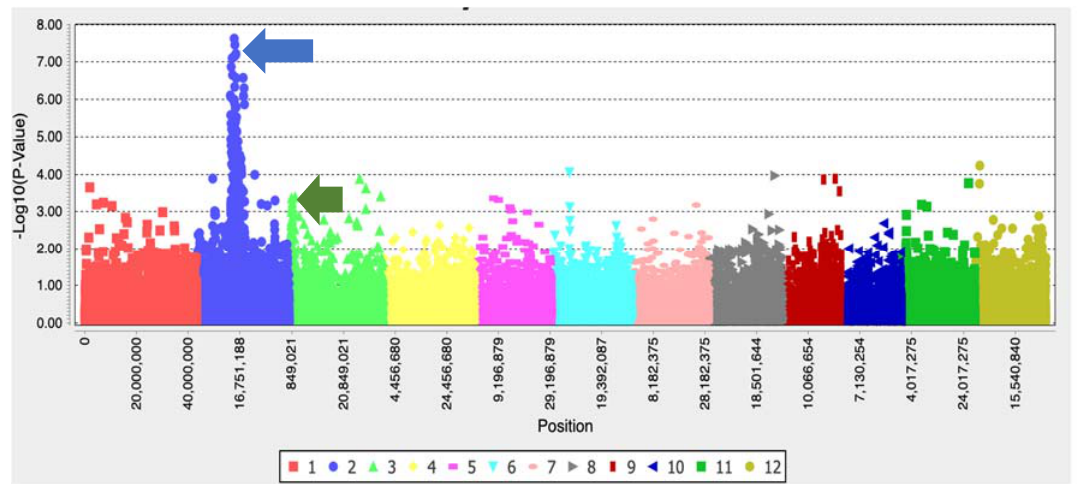
Figure 4. Manhattan plot showing a peak on chromosome 2 (blue arrow) (with –log10 ( p -value) > 5.8) where the ALS gene is located. A lower peak on chromosome 3 (green arrow) was identified as a potential gene contributing toward IMI resistance in weedy rice.